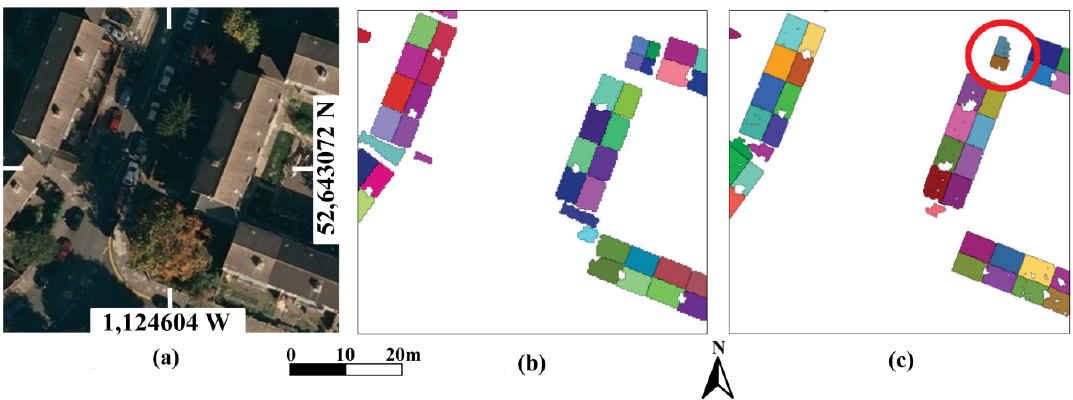
Figure 8. Extracted roof planes of the Leicester test site. ( a ) Aerial image; ( b ) Roof planes extracted from LiDAR DSM; ( c ) Roof planes extracted from DSM derived from aerial images. Aerial image: copyright © Bluesky International Ltd. (Leicestershire, UK). Derived from data © Crown copyright and database right 2012 Ordnance Survey licence number 100042840.